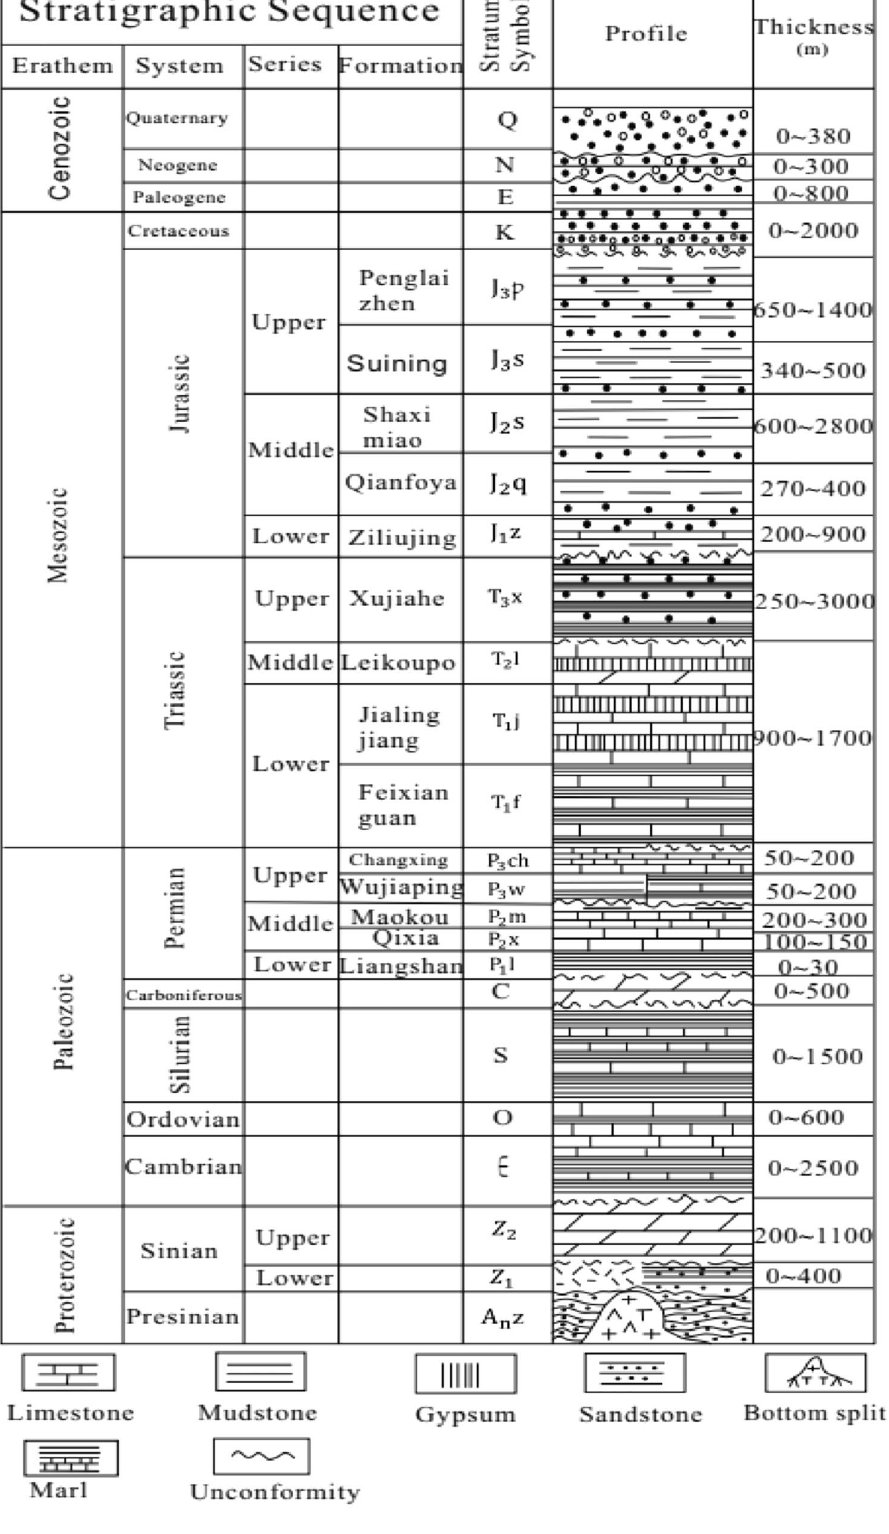
Fig. 3 Comprehensive histo- gram of Sichuan basin